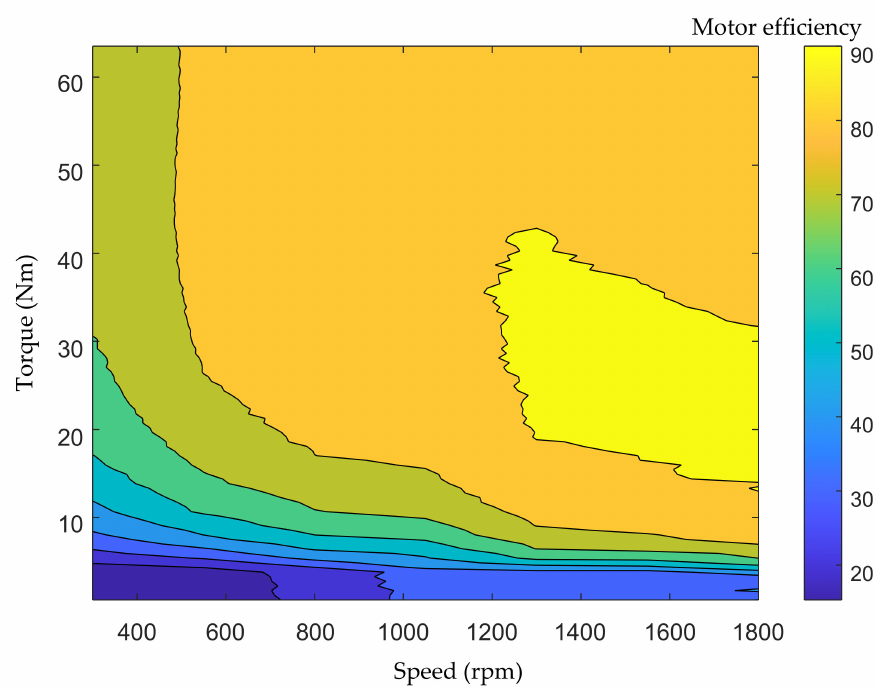
Figure 18. Efficiency map of